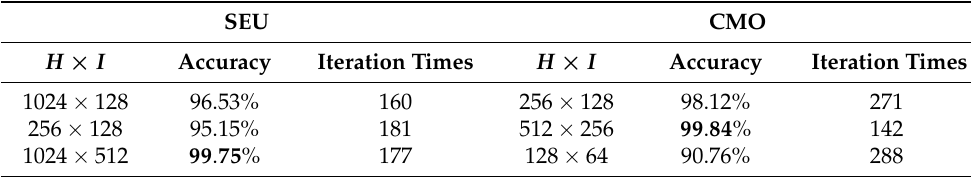
Table 5. AE-MSGCN performance with respect to different hidden layer